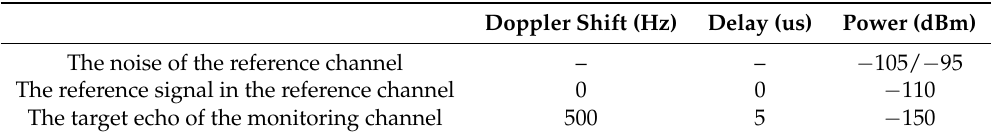
Table 1. Parameter setting.